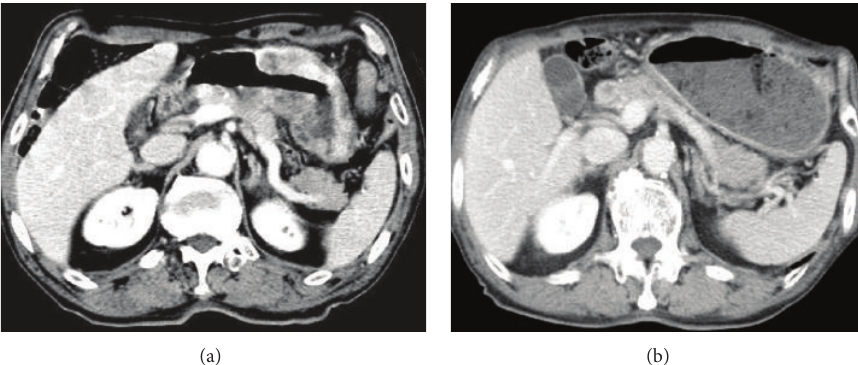
Figure 3: Computed tomography (CT) imaging. (a) The remarkable thickened gastric wall which suggested the invasion of the pancreas was depicted before chemotherapy. (b) Normalized gastric wall and separated gastric wall and pancreas was seen after chemotherapy.